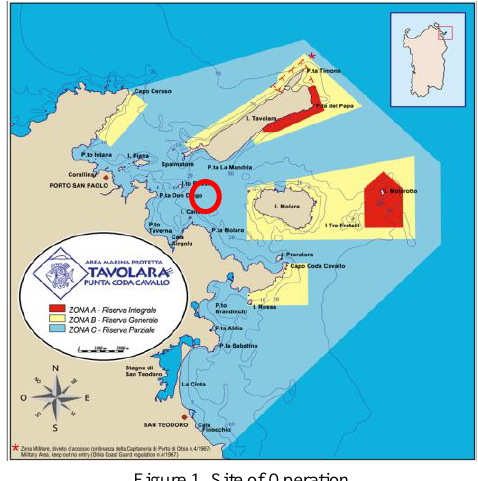
Figure 1. Site of Operation